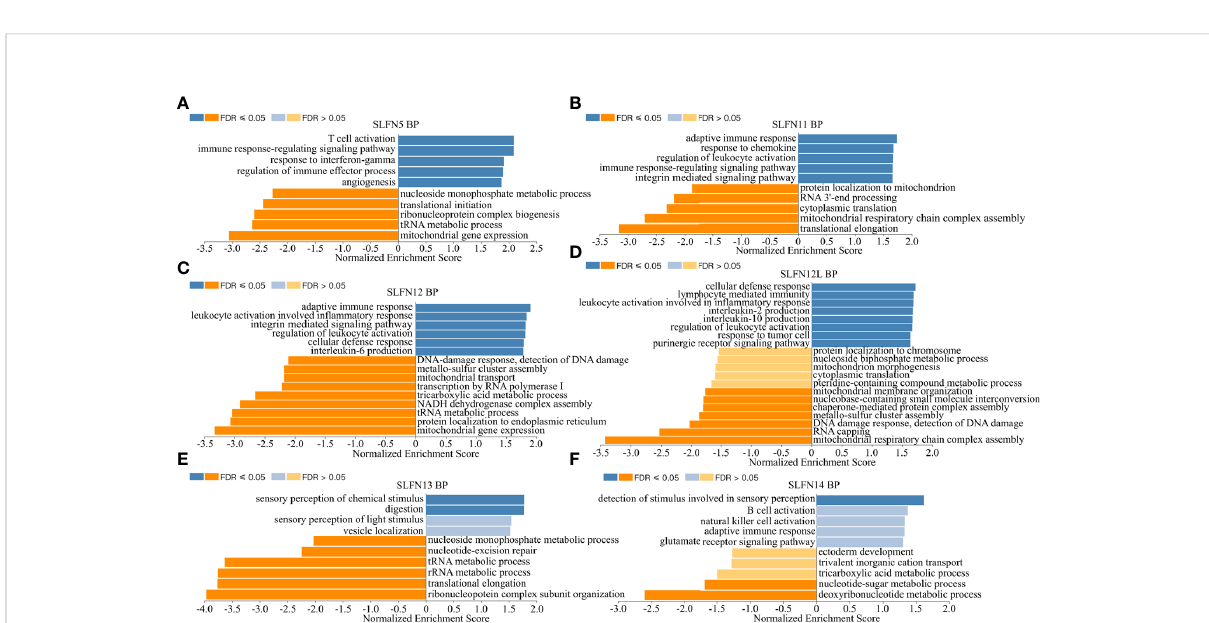
FIGURE 6 Biological functions of SLFN family members. Using Gene Set Enrichment Analysis (GSEA) module of LinkedOmics database to conduct functional enrichment for different SLFN members. (A) The biological process of SLFN5 suggests related to T cell activation, immune response, and immune regulation. (B) The biological process of SLFN11 related to adaptive immune response and immune regulation. (C) The biological process of SLFN12 related to adaptive immune response, leukocyte activation. (D) The biological function of SLFN12L related to lymphocyte- mediated immune response and in fl ammatory mediated leukocyte activation. (E) The biological function of SLFN13 is related to stimulus- response. (F) The biological function of SLFN14 is related to B cell